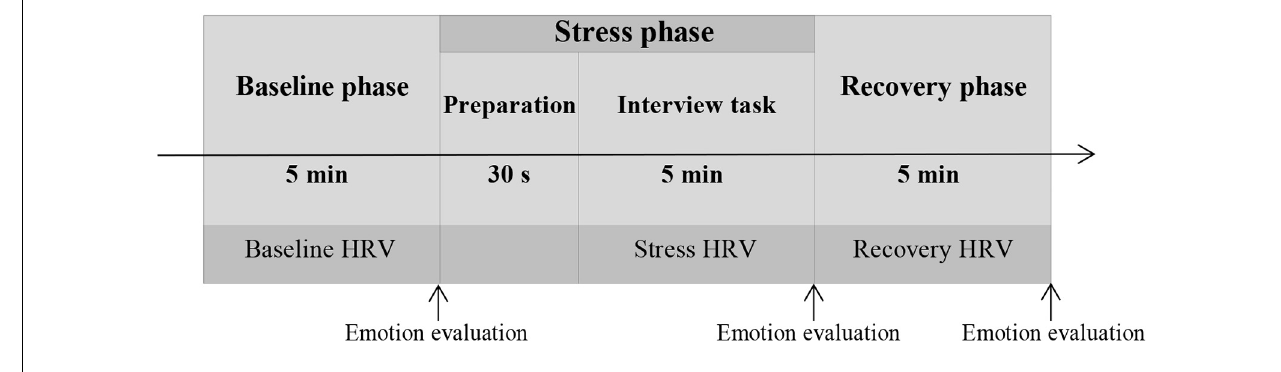
FIGURE 1 | Experimental flow diagram. TABLE 1 | Emotional experience and HRV values in three experimental phases (mean ± standard deviation).